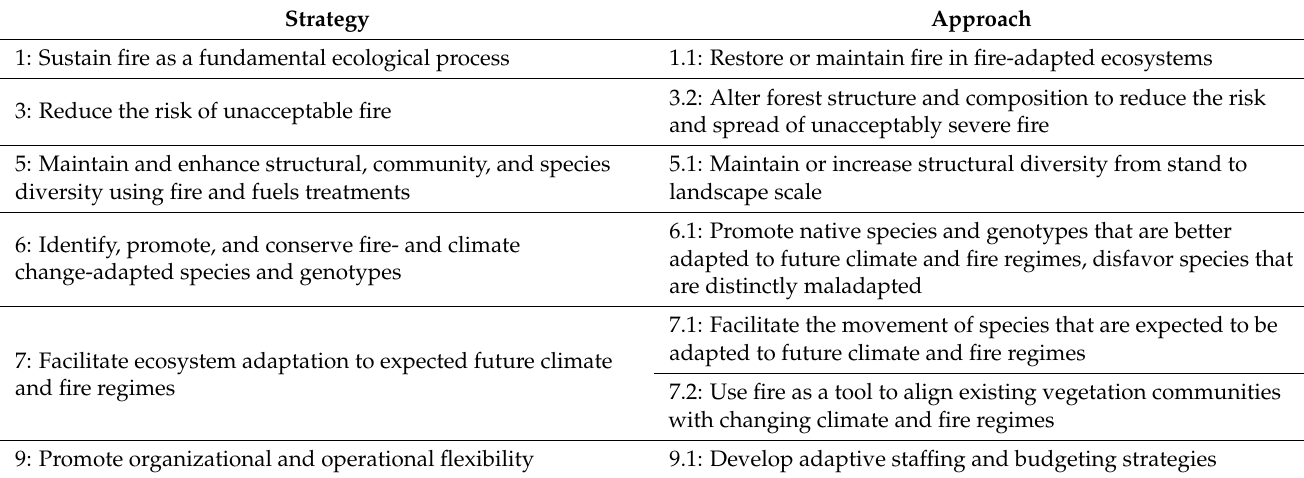
Table 2. Adaptation strategies and approaches selected during the KPERP